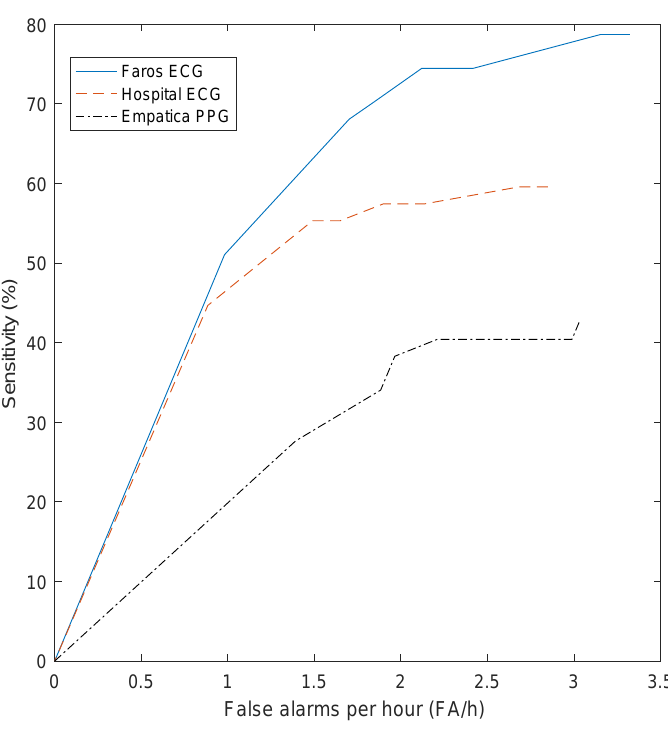
Figure 2. The sensitivity and false alarm rate for different thresholds of the support vector machine (SVM)